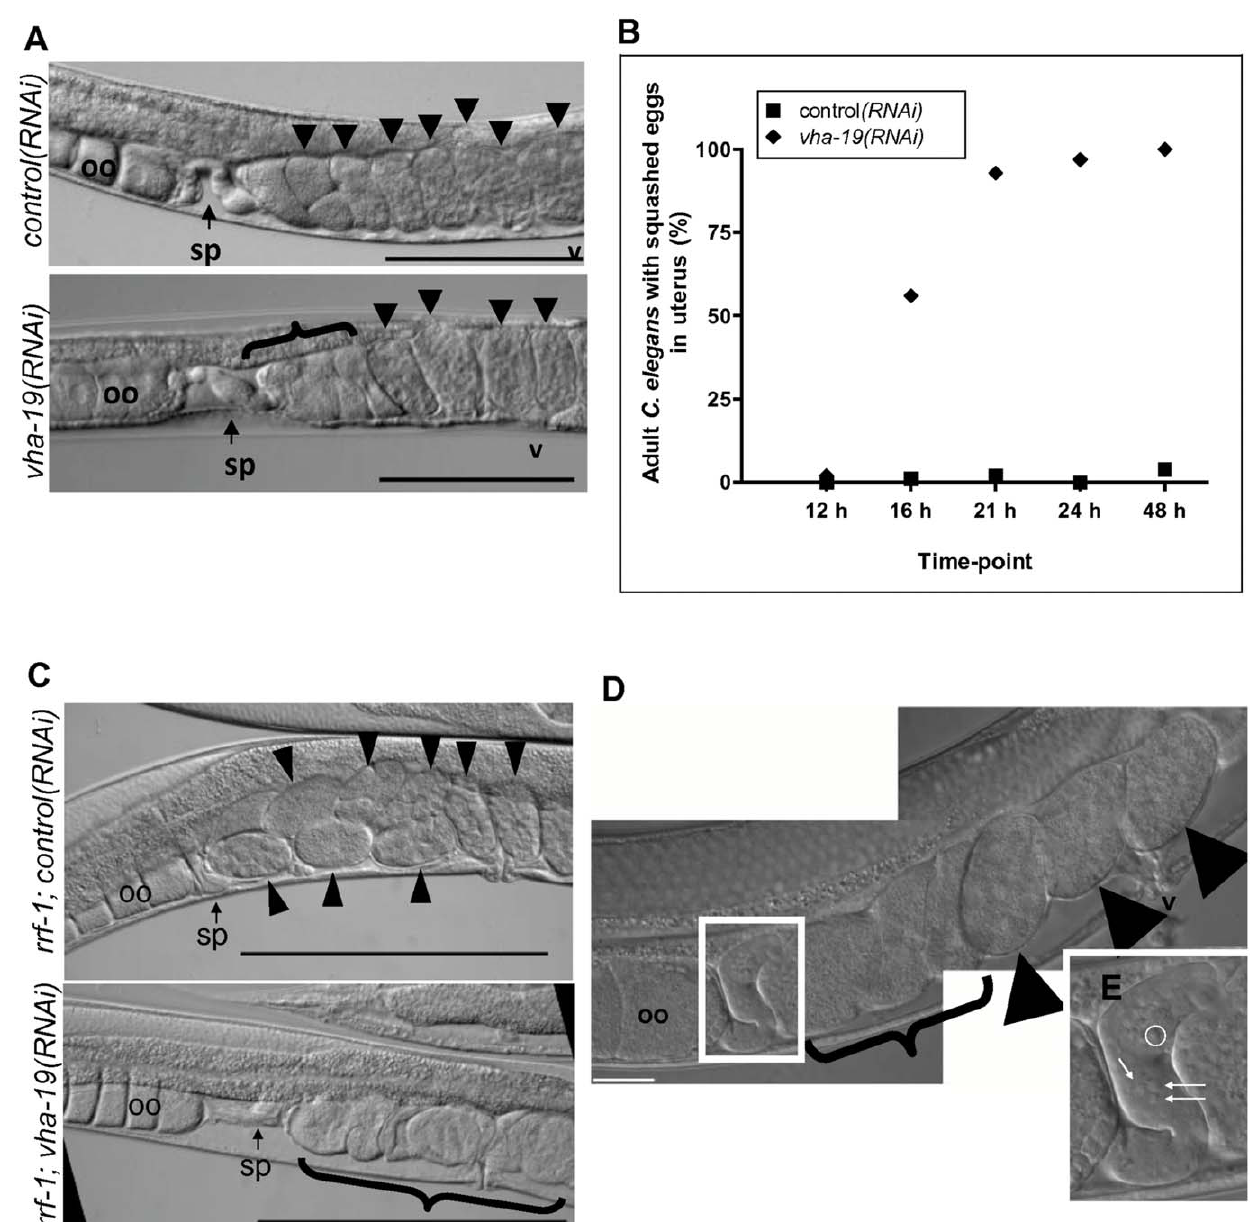
Figure 1. vha-19(RNAi) adults lay compressed eggs despite the presence of sperm in the spermatheca. Wild type (A-B, D) or rrf-1 (C) C. elegans were fed control or vha-19 dsRNA from the L4 stage for 16–48 hours. A) The proximal gonad of a control(RNAi) and vha-19(RNAi) adult after feeding on dsRNA for 16 hours. B) The percentage of control(RNAi) or vha-19(RNAi) adults that had one or more compressed (squashed) eggs present in their uterus from 16–48 h. At least 89 worms were scored for each experimental group at each time point. C) The proximal gonads of rrf-1(pk1471) C. elegans after feeding on dsRNA for 24 hours. D) A typical proximal gonad of a wild type C. elegans that was fed vha-19 dsRNA from the L4 stage for 24 hours. Note the presence of newly released, compressed eggs in the uterus (bracket), even though there are sperm in the spermatheca (enclosed by a white box and magnified in E. Examples of sperm are indicated by arrows or enclosed by a white circle). In all images black arrowheads indicate normal embryos, and a bracket indicates compressed eggs. The oocytes (oo) and spermatheca (sp) are also indicated. v= vulva. Scale bars represent 100 m m in A and C and 10 m m in D. doi:10.1371/journal.pone.0040317.g001 Regardless of the time point at which they were isolated, ment. Because vha-19(RNAi) embryos were compressed (Figure 1A), we investigated their eggshell. The C. elegans eggshell forms shortly approximately 80% (n= 59) of isolated vha-19(RNAi) embryos had after fertilization [7], provides mechanical and osmotic support for a visible eggshell (Figure 4A). Some vha-19(RNAi) embryos had a the embryo [24], and has been shown to be faulty when expression clearly visible eggshell even when they were compressed (Figure 4A), indicating that the structural fidelity, but not the of known components of the secretory pathway are silenced by RNAi [20]. presence, of the eggshell is dependent on vha-19 expression. In